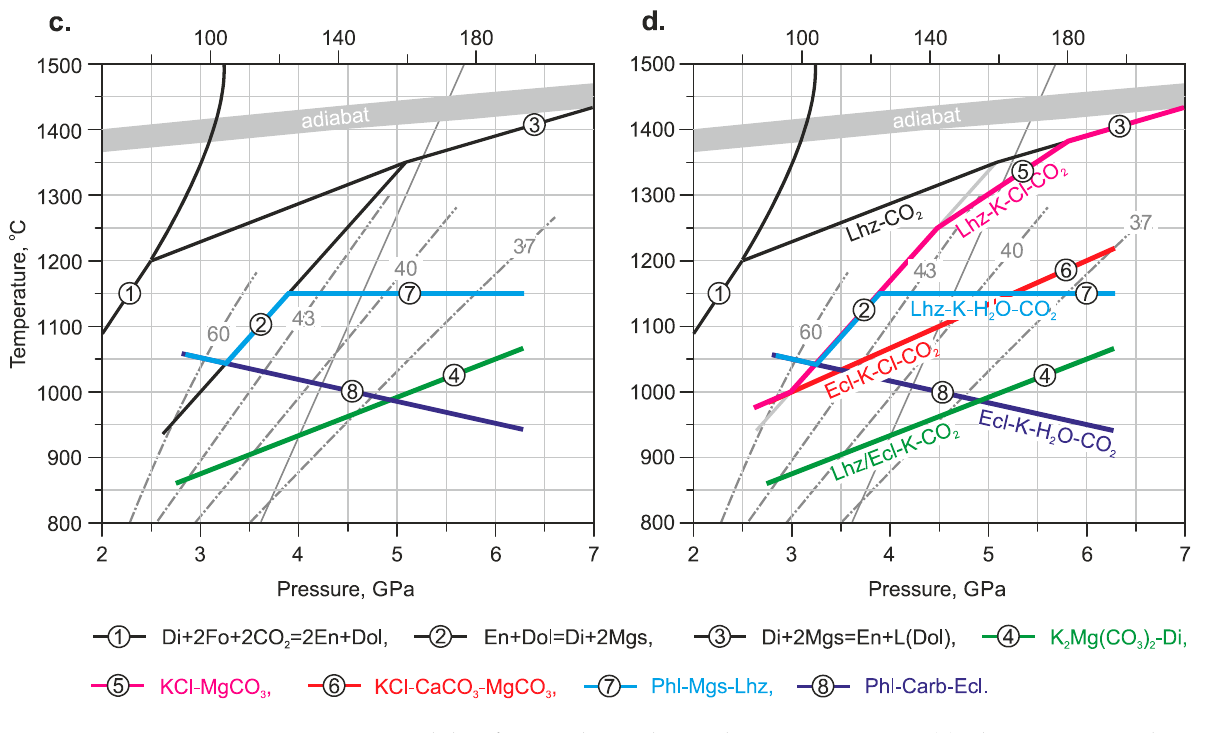
Figure 9. Solidi of K-, Cl-, and CO 2 -bearing systems: ( a ) the systems KCl+MgCO 3 , KCl+CaCO 3 +MgCO 3 , and diopside-K 2 Mg(CO 3 ) 2 ; ( b ) expected solidi of the peridotite-KCl-MgCO 3 system (magenta) and peridotite-K 2 Mg(CO 3 ) 2 system (green); ( c ) the systems carbonated phlogopite lherzolite (light blue), carbonated phlogopite eclogite (violet), diopside-K 2 Mg(CO 3 ) 2 (green); ( d ) comparison of solidi of peridotite containing KCl+Mgs (magenta), Phl+Mgs (light blue), and K 2 Mg(CO 3 ) 2 (green), and eclogite containing KCl+Dol (red), and Phl+Dol (violet). Dashed-dotted lines denote continental geotherms with the surface heat flow of 37, 40, 43 mW/m 2 [61]. ‘adiabat’— mantle adiabat is after [62]. (1)—[63,64], (2)—[65], (3)—[66], (4)—[67], (5), (6)—[32] and this study, (7)—[68], (8)—[69].